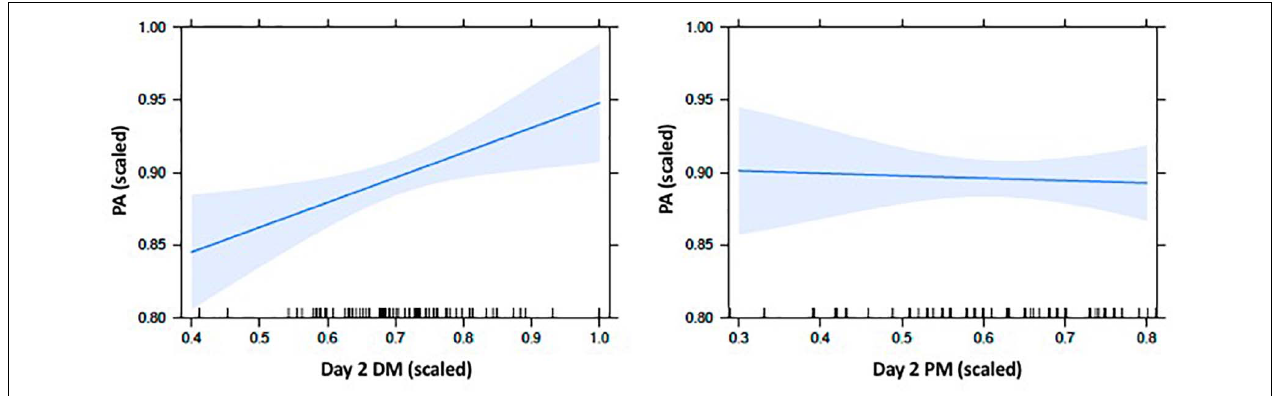
FIGURE 1 | Effect plots for Session 2 memory abilities on phonological awareness (PA). Figure depicts the relative predictive relationships between PA and declarative memory (DM) and PA and procedural memory (PM), assessed after an overnight delay, and controlled for site. Values for all variables are scaled according to the proximity-to-maximum method (Moeller, 2015). Graphs were generated using the package “effects” in R (Fox et al., 2016). Shaded regions represent the pointwise confidence band for the predictor effects, based on standard errors calculated from the covariance matrix of the fitted regression coefficients (Fox and Weisberg, 2018).